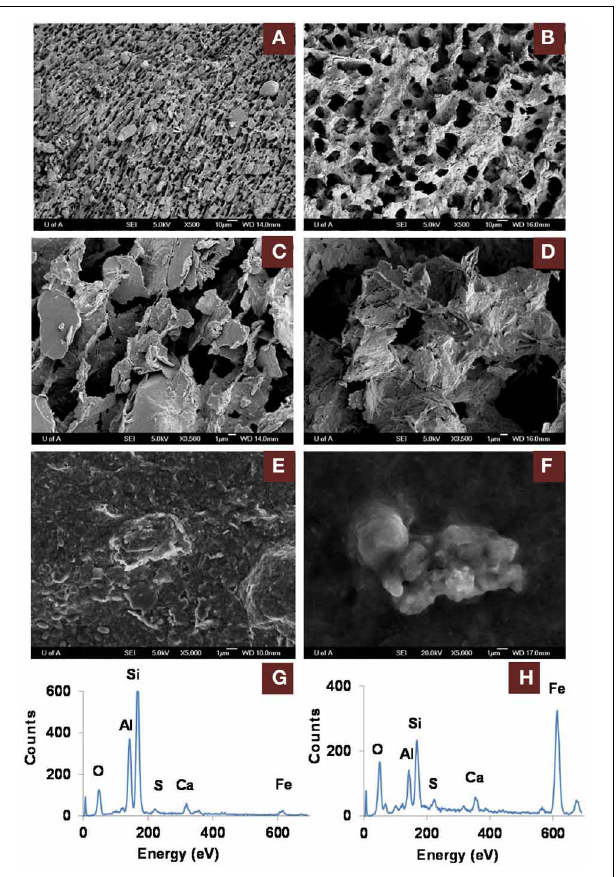
FIGURE 5 | Scanning electron microscope (SEM) micrographs of clay architecture in amended and unamended MFT at 213 days incubation. (A–D), cryo-SEM; (E,F) , conventional SEM. (A) Unamended MFT with random clay particle structure; scale bar 10 μ m. (B) Canola-amended MFT with flocculated clay particles (light) having card-house structure, producing a network of interstitial pores (dark); scale bar 10 μ m. (C) Phyllosilicate particles in unamended MFT, lacking transformed mineral coating; scale bar 1 μ m. (D) Phyllosilicate particles in amended MFT, forming aggregates with amorphous surface coating; scale bar 1 μ m. (E) Weakly aggregated phyllosilicate particles in unamended MFT. (F) Aggregated phyllosilicate particles in amended MFT. (G) Energy dispersive spectrum (EDS) of (E) showing phyllosilicates with negligible iron mineral coating. (H) EDS of (F) revealing phyllosilicates coated with amorphous iron